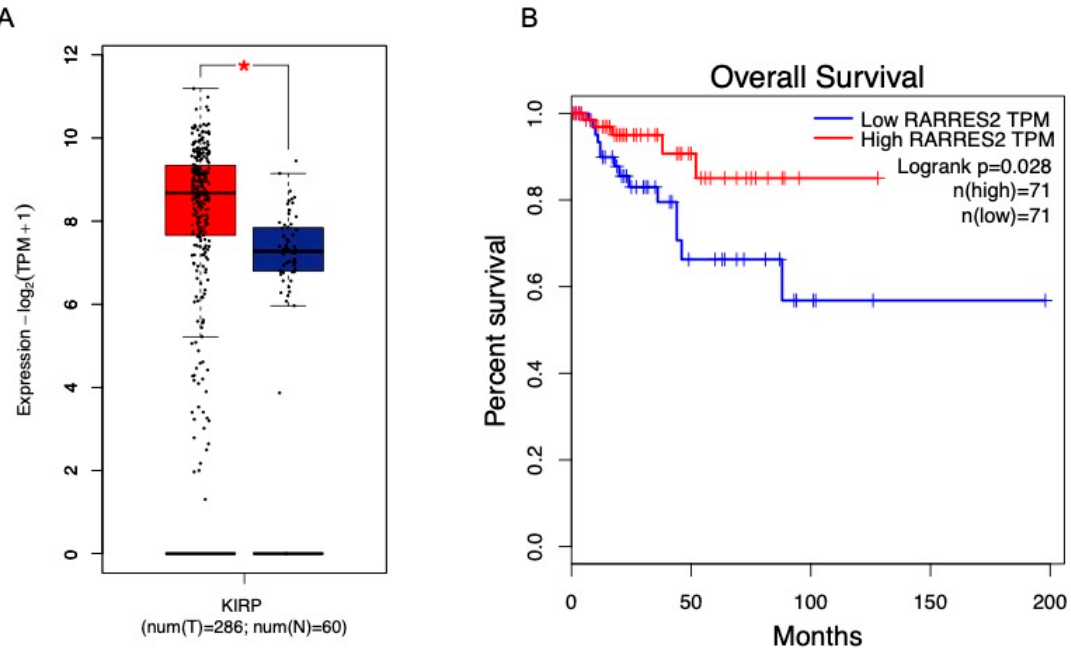
Figure 7. Chemerin expression is increased in papillary renal cell carcinoma (pRCC or KIRP) and is associated with higher overall survival. The Gene Expression Profiling Interactive Analysis (GEPIA) web server [106] was used for RNA sequencing expression analysis of chemerin in pRCC (red bar) and normal renal samples (blue bar) from the Cancer Genome Atlas (TCGA) and Genotype-Tissue Expression (GTEx) projects ( A ). The GEPIA web server survival analysis tool [106] was used to compare the overall survival of the quartile of pRCC patients with the highest chemerin expression (red line) versus the quartile of pRCC patients with the lowest chemerin expression (blue line) ( B ). * p < 0.01. TPM, transcripts per kilobase million. 10. Thyroid Cancer